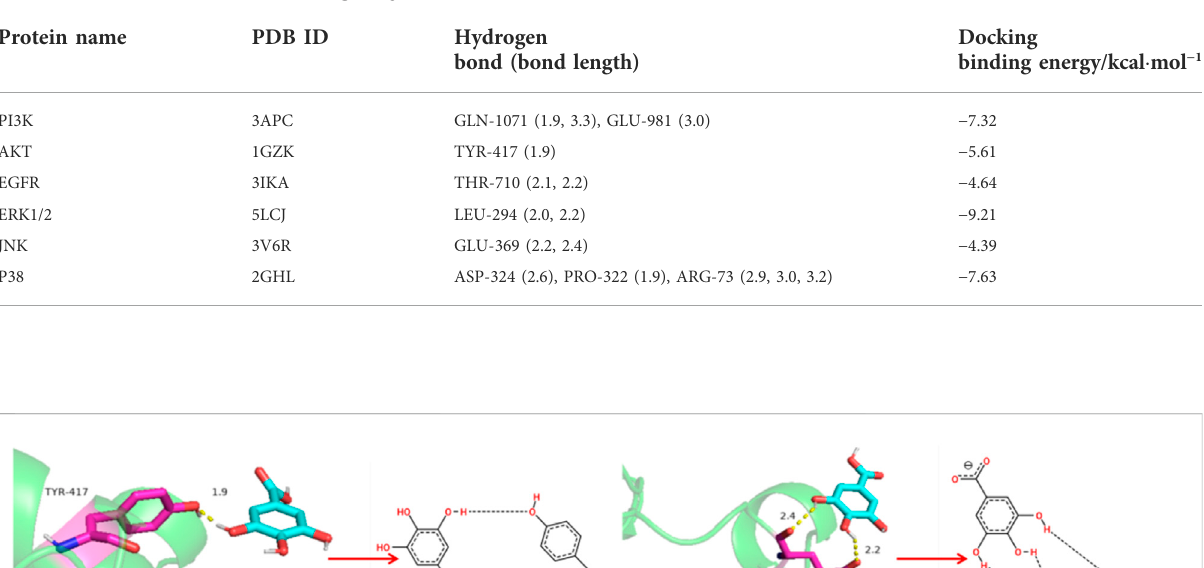
TABLE 2 Information of molecular docking analysis.